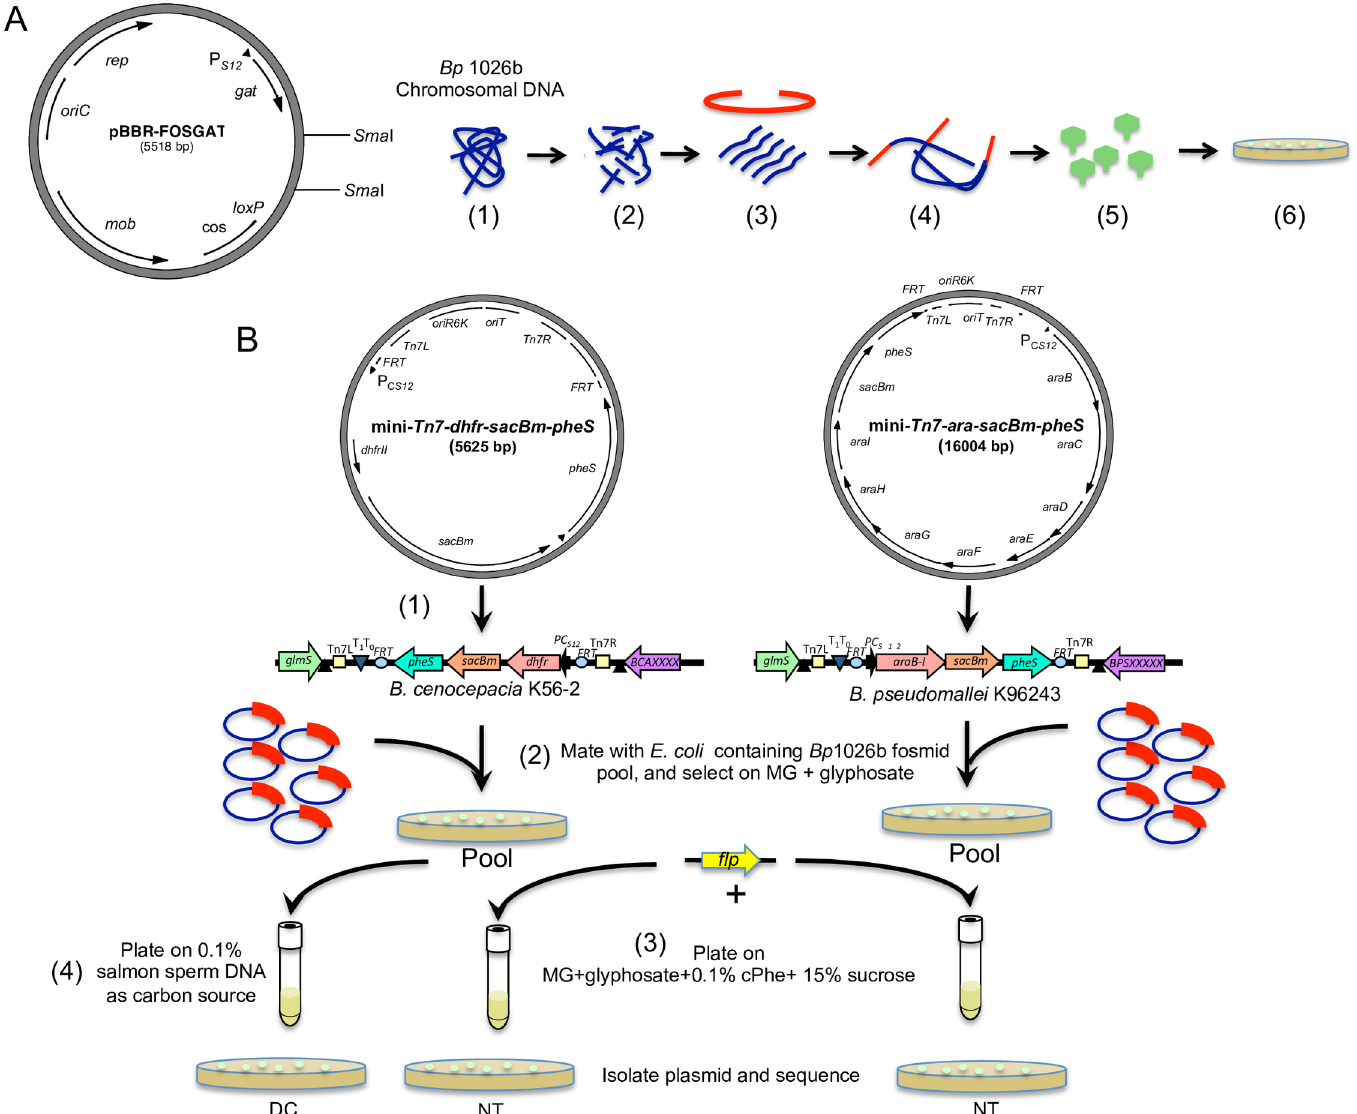
Fig 2. Library production and counter-selection scheme. (A) Plasmidmap of an in-lab created pBBR-FOSGAT and strategy for creating the fosmid library. Bp 1026b chromosomal DNA (1) was sheared(2), and approximately 50-Kbp size fragments were ligated to pBBR-FOSGAT fosmid vector DNA (3 and 4; fosmid vector indicatedin red). The ligated DNA was then packagedinto λ -phageparticles (5) and the particlesare used to infect E . coli host cells (6). (B) Counter-selection scheme to screen for fosmid clones enablingDNA uptake or DNA catabolism. (1) pheS and sacB counter-selectable markers were inserted into Bc K56-2 and Bp K96243chromosomes through minTn7 integration.(2) The E . coli library containing fosmid pool from (A) was conjugated with Bc K56-2 and Bp K96243containing pheS and sacB counter-selectable markers. (3) Coloniesfrom these two Burkholderia strains were individuallypooled and incubatedwith flp -DNA, allowingtransiently expressedFlp to excise the chromosomally integratedcounter-selection markers and counter-selectedon media containingcPhe and sucrose. (4) Alternatively, the Bc K56-2 pool was selected on minimal medium containing purifiedsalmon sperm DNA as a sole carbon